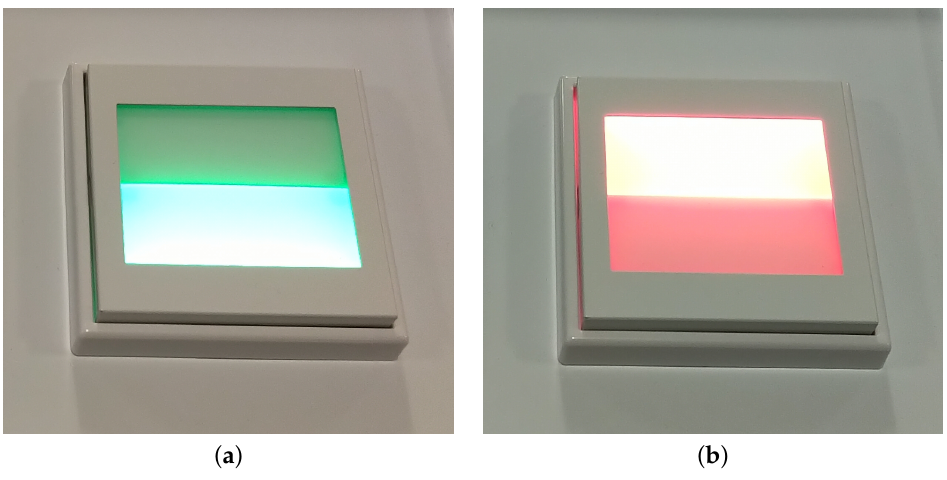
Figure 8. Demonstrator of an ESL: ( a ) ESL is green. ( b ) ESL glows